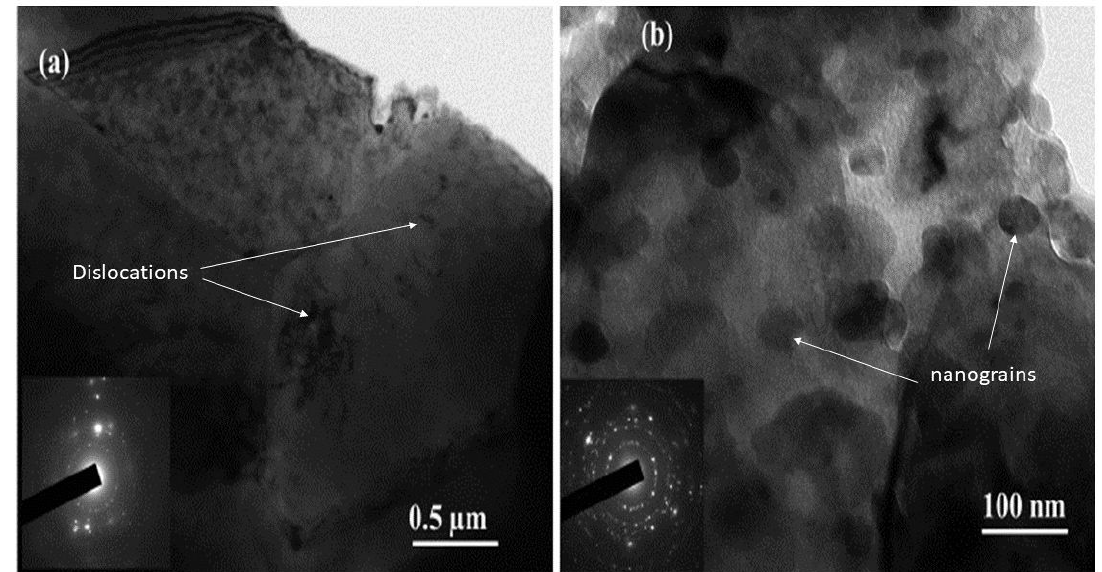
Figure 5. TEM bright field images (a) as-SPSed sample and (b) as-extruded